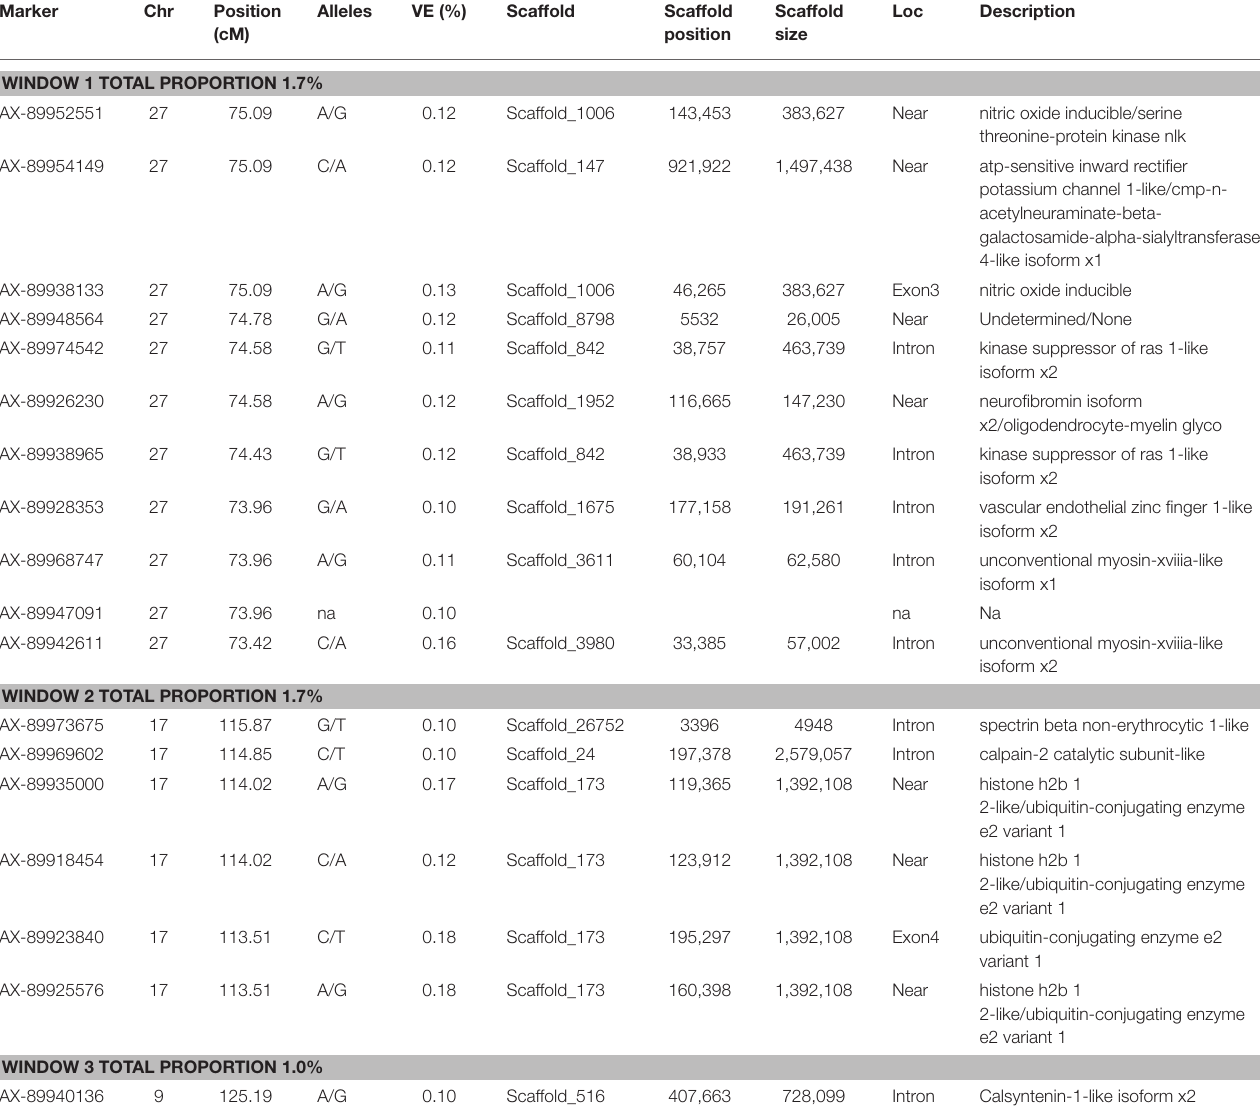
Chr, chromosome; VE, percentage of the genetic variance explained by the SNP; Loc, location in the scaffold with three possibilities: intron, exon, or near an exon. 21 nodes were genes detected by the wssGWAS analysis